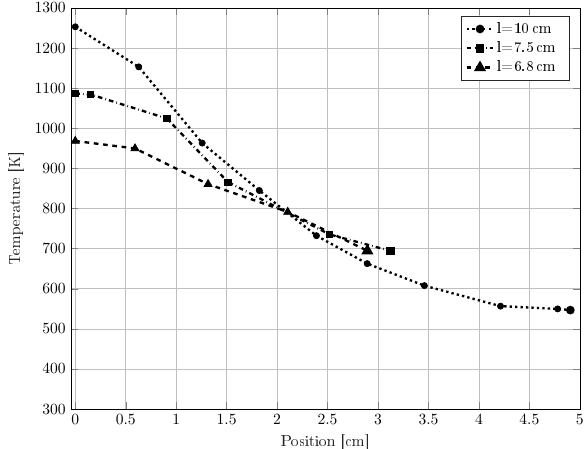
Figure 6. Measurement of the temperature distributions for different lamp lengths. The zero was set at the hottest point.